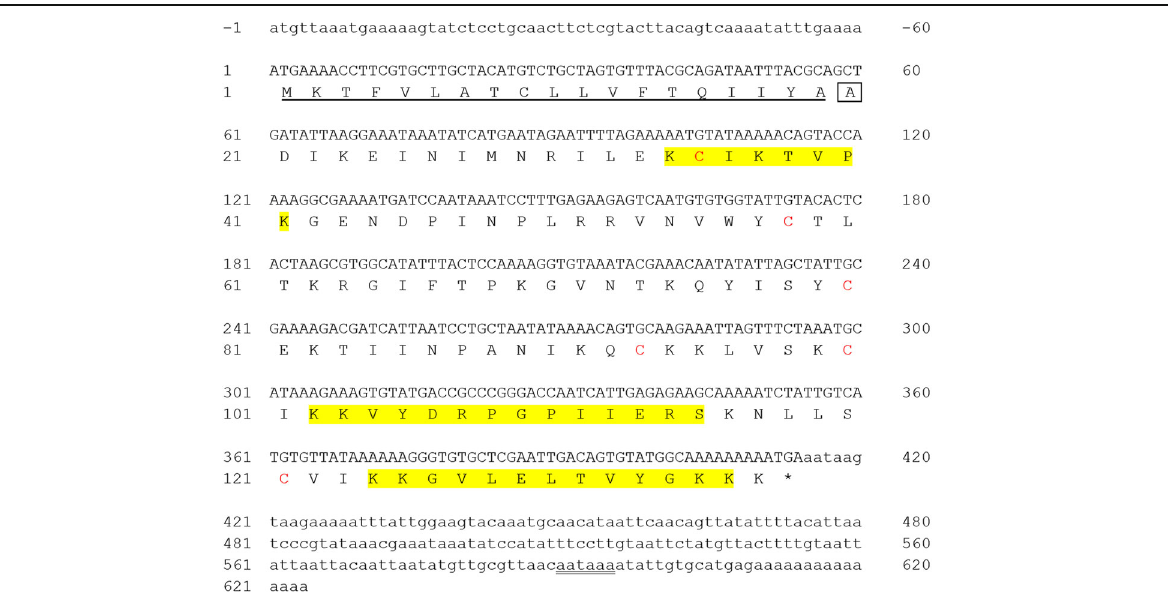
Fig. 1 Full-length DNA sequence and translation of the region encoding the Sol g 4.1 protein. Yellow-shaded areas were verified by LC-MS/MS of a partial amino acid sequence. The leader sequence is underlined. The 5 ΄ and 3 ΄ UTRs are indicated by small letters, and the poly (A) tail initiation signal is double underlined. The boxed residue was determined by automated Edman degradation sequencing. The red letters represent cysteines residues, and the termination codon is indicated by